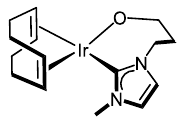
Figure 11. Complex 8 .